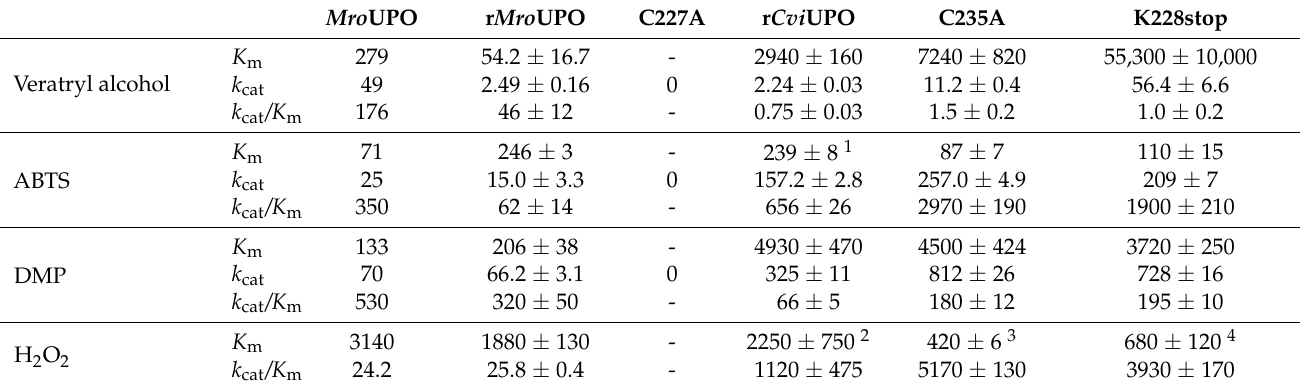
Table 3. Kinetic constants— K m ( µ M), k cat (s − 1 ), and k cat / K m (s − 1 · mM − 1 )—of wild Mro UPO [22], recombinant r Mro UPO and its C227A variant, and recombinant r Cvi UPO and its C235A and K228stop